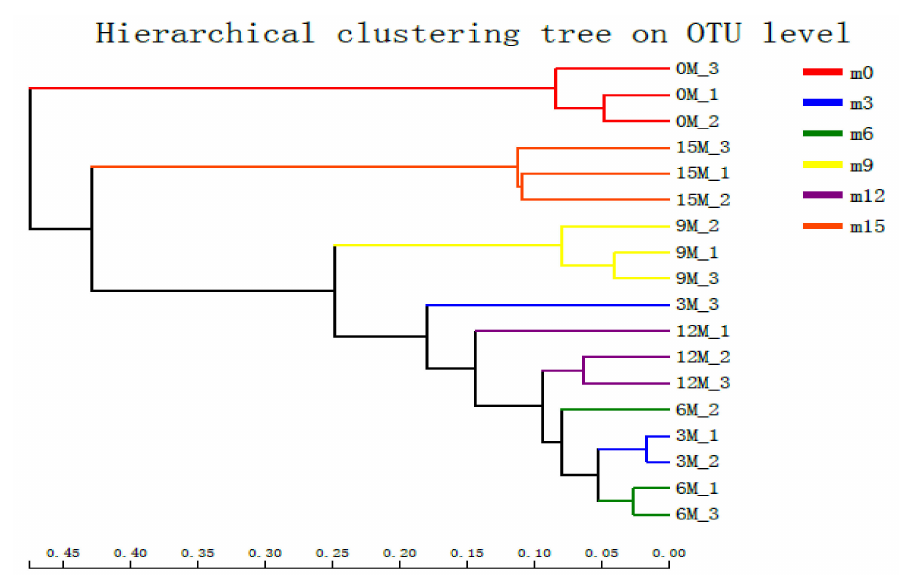
Figure 5. Beta diversity heat map analysis of bacterial communities in fish sauce at di ff erent fermentation